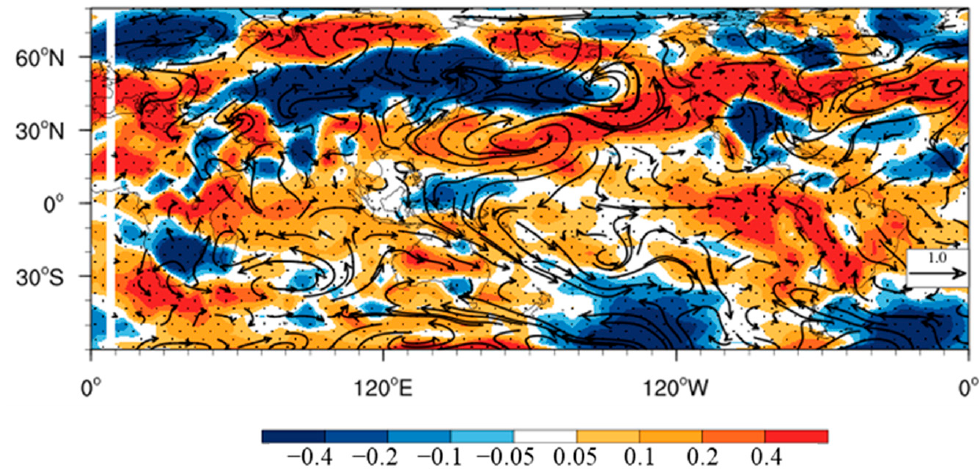
Figure 10. Same as Figure 8, but from NESM3.0 with climatological SST in the Northeast Pacific.